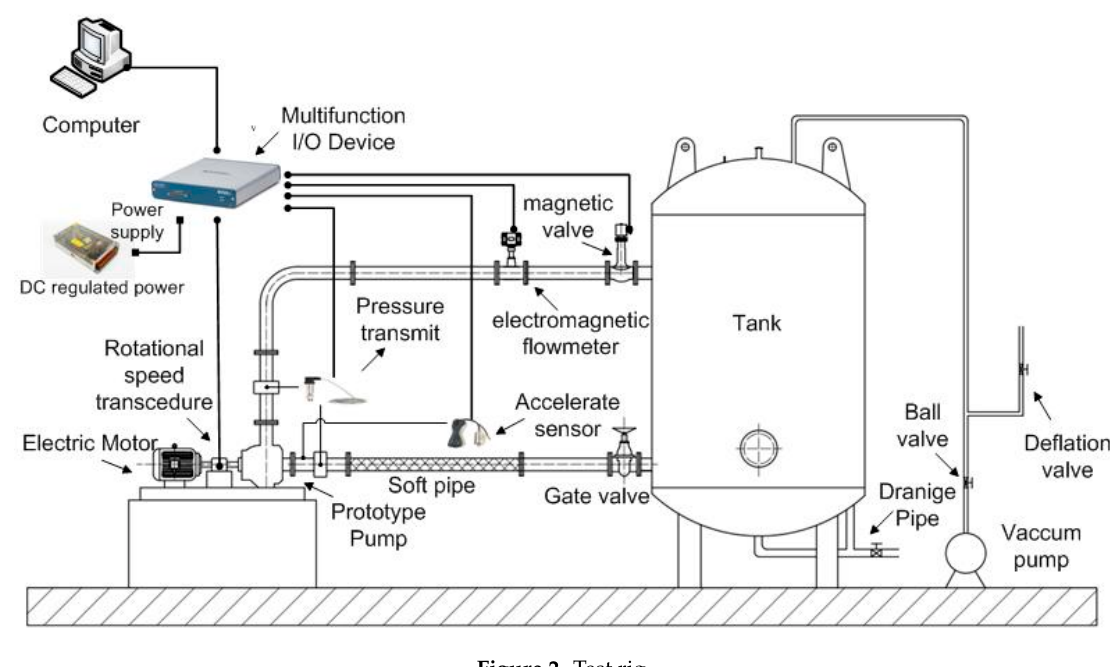
Figure 2. Test rig.